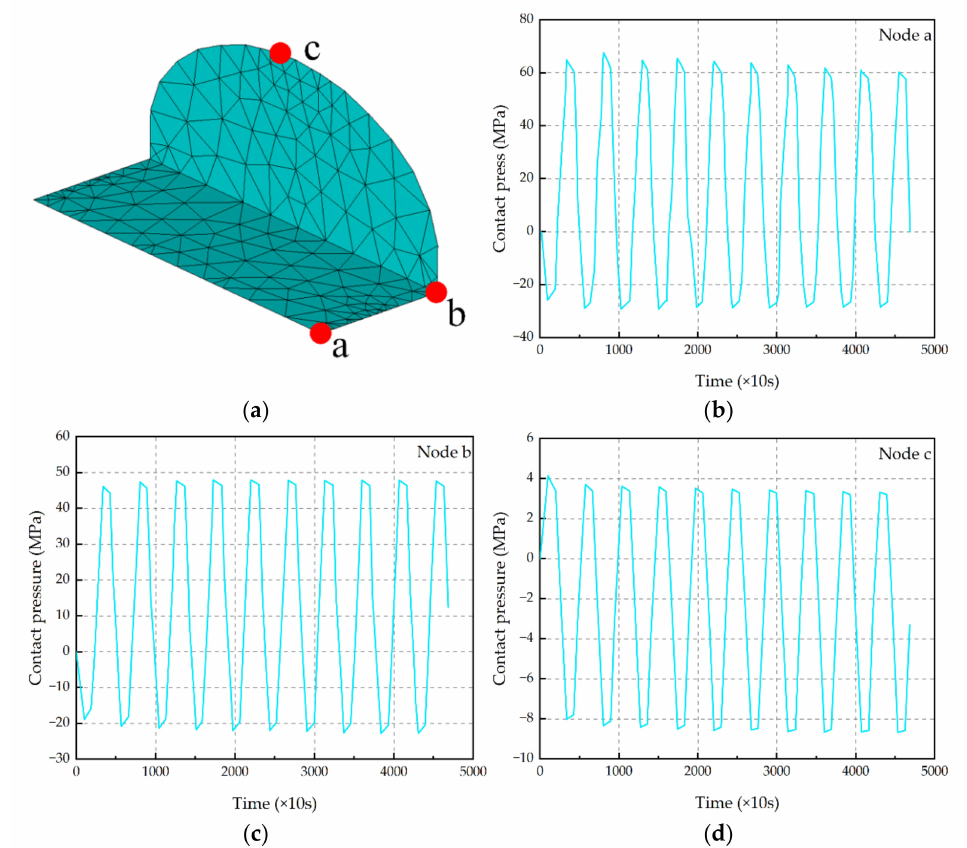
Figure 10. Critical points at interface 1 and interface 2 and contact pressure evolution in these critical points. ( a ) Points a, b and c are the location of the critical point; ( b ) contact pressure evolution in critical point a; ( c ) contact pressure evolution in critical point b; ( d ) contact pressure evolution in critical point